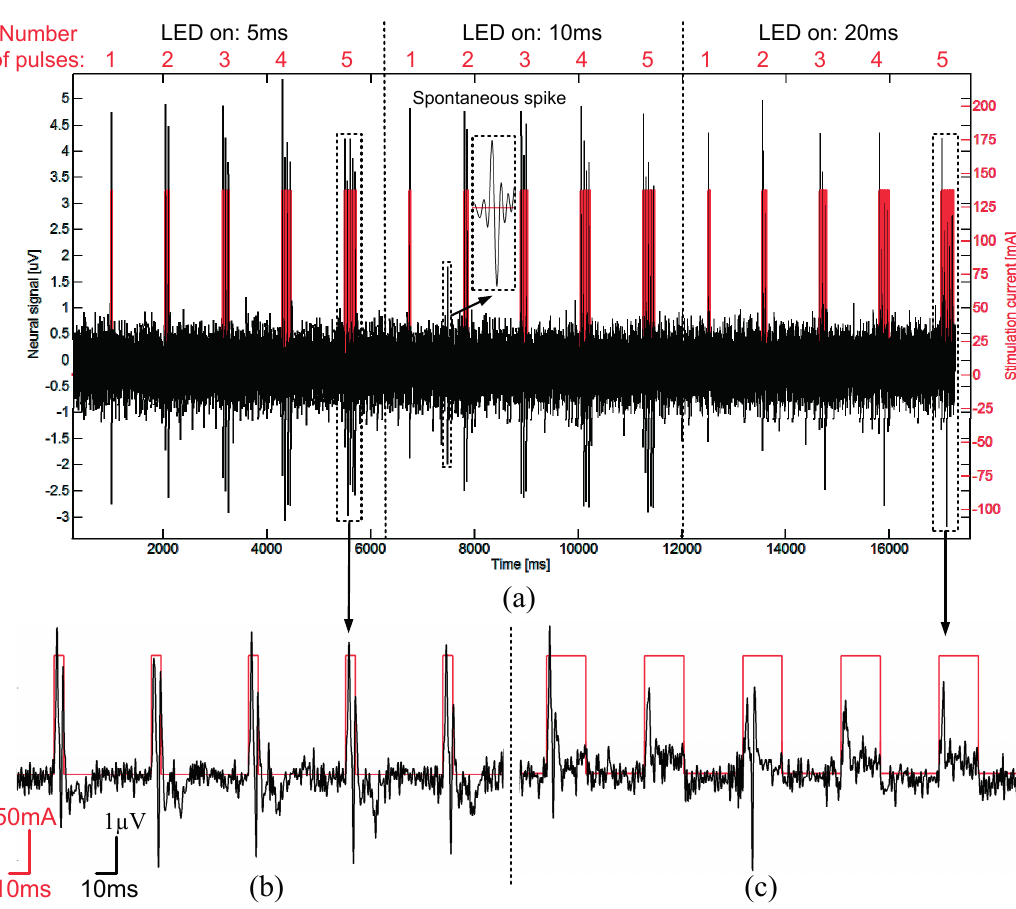
Figure 14. ( a ) Experimental results showing extracellular spike responses to three different pulse sequences (one to five pulses) with different durations per pulse (5, 10, 20 ms); ( b ) Enlargement of a five pulse train (5 ms duration per pulse); ( c ) Enlargement of a five pulse train (20 ms duration per pulse). The longer pulse stimulation paradigm induced progressively failing spiking